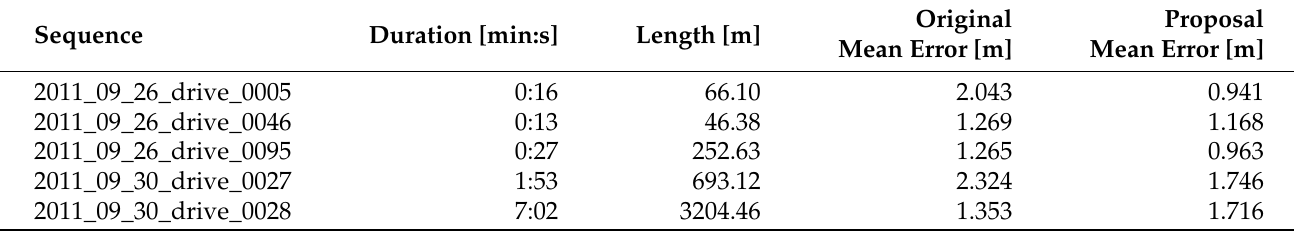
Table 1. Mean results on KITTI sequences. Original is our previous work adapted with permission from ref. [28]. Copyright 2015 Copyright IEEE, without any building component, Proposal is this work.